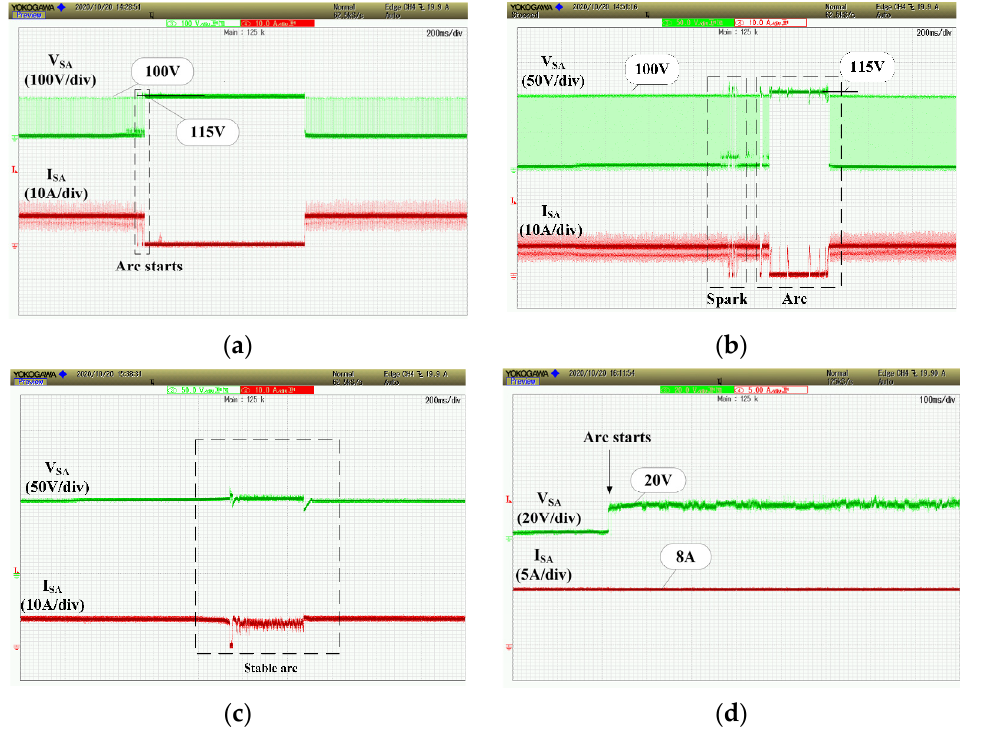
Figure 24. Influence of arc on SA working point; ( a ) Stable arc in switching mode; ( b ) Intermittent arcs in switching mode; ( c ) Stable arc in bus feeding mode; ( d ) Stable arc in shunt mode.